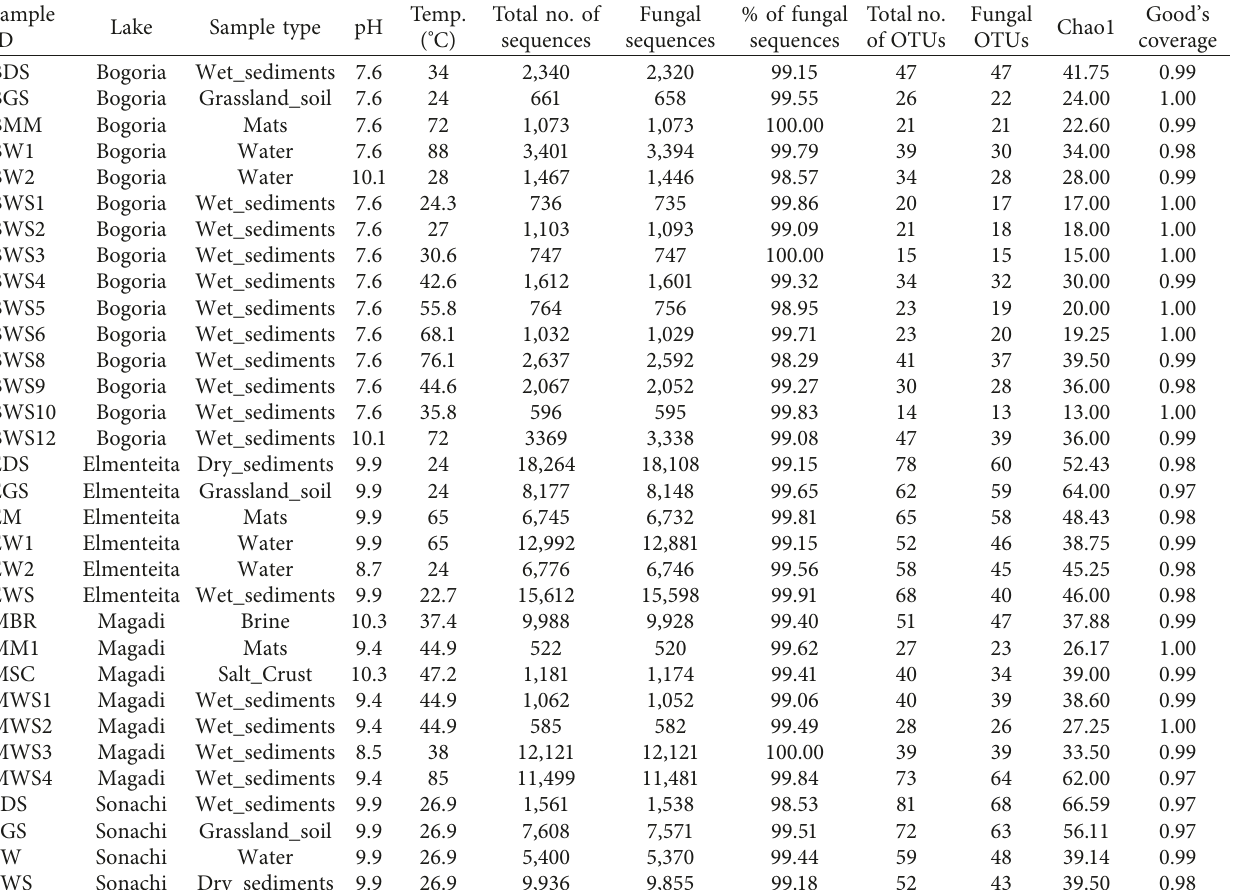
Table 1: Summary description of the 33 samples investigated and their diversity indices. Sample